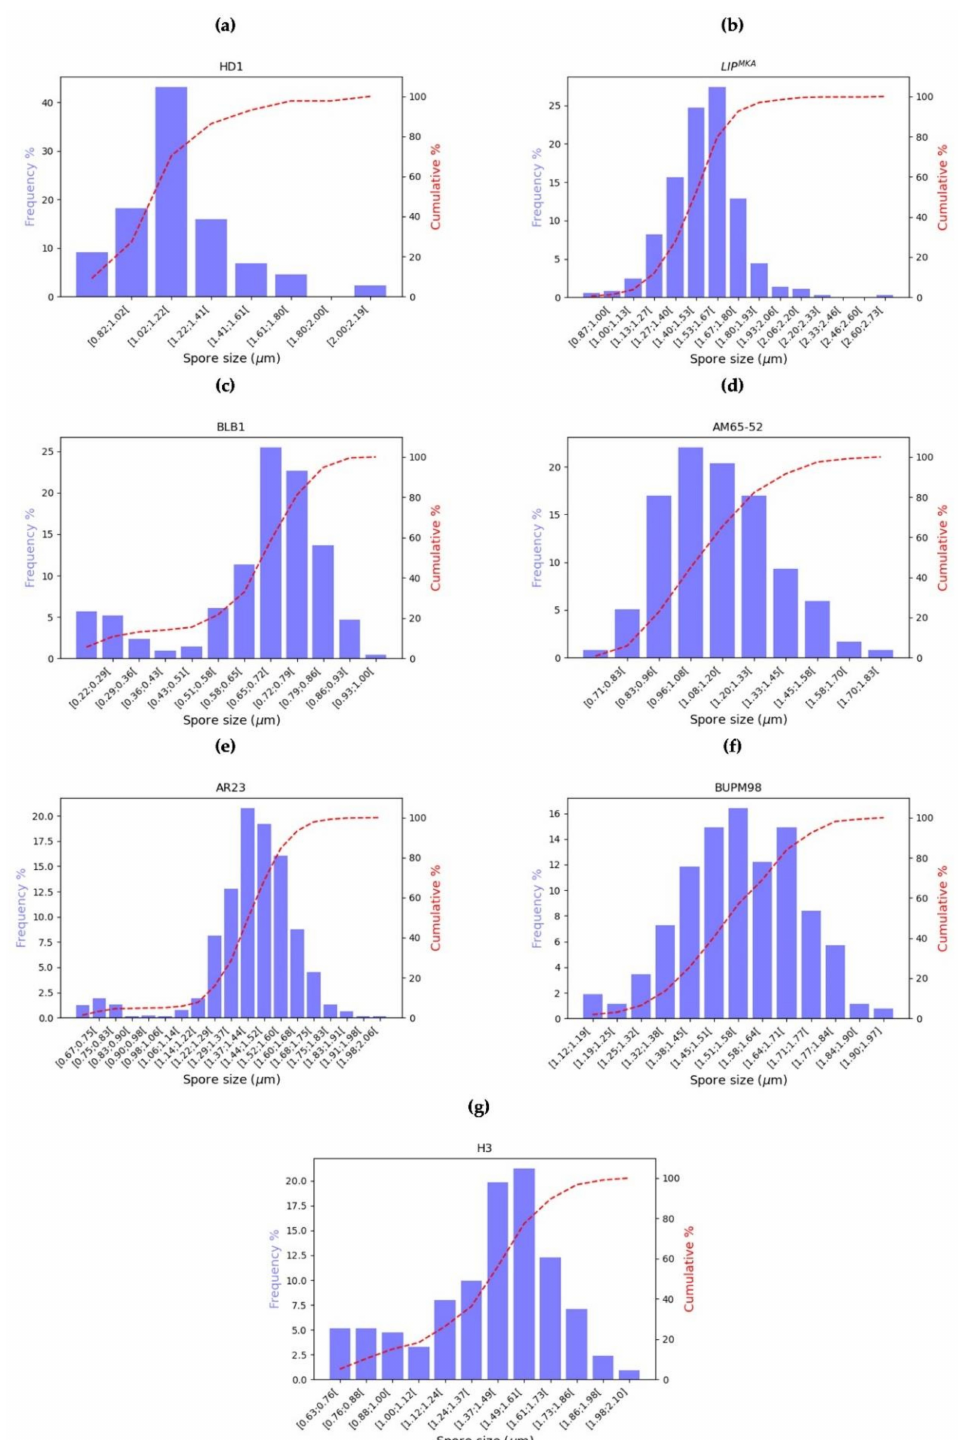
Figure 9. Histograms representing the size distribution in terms of frequency and cumulative percentage of the length L of the spores synthesized by the seven strains of B. thuringiensis : ( a ) HD1, ( b ) LIP MKA , ( c ) BLB1, ( d ) AM65-52 ( e ) AR23, ( f ) BUPM98 and ( g )